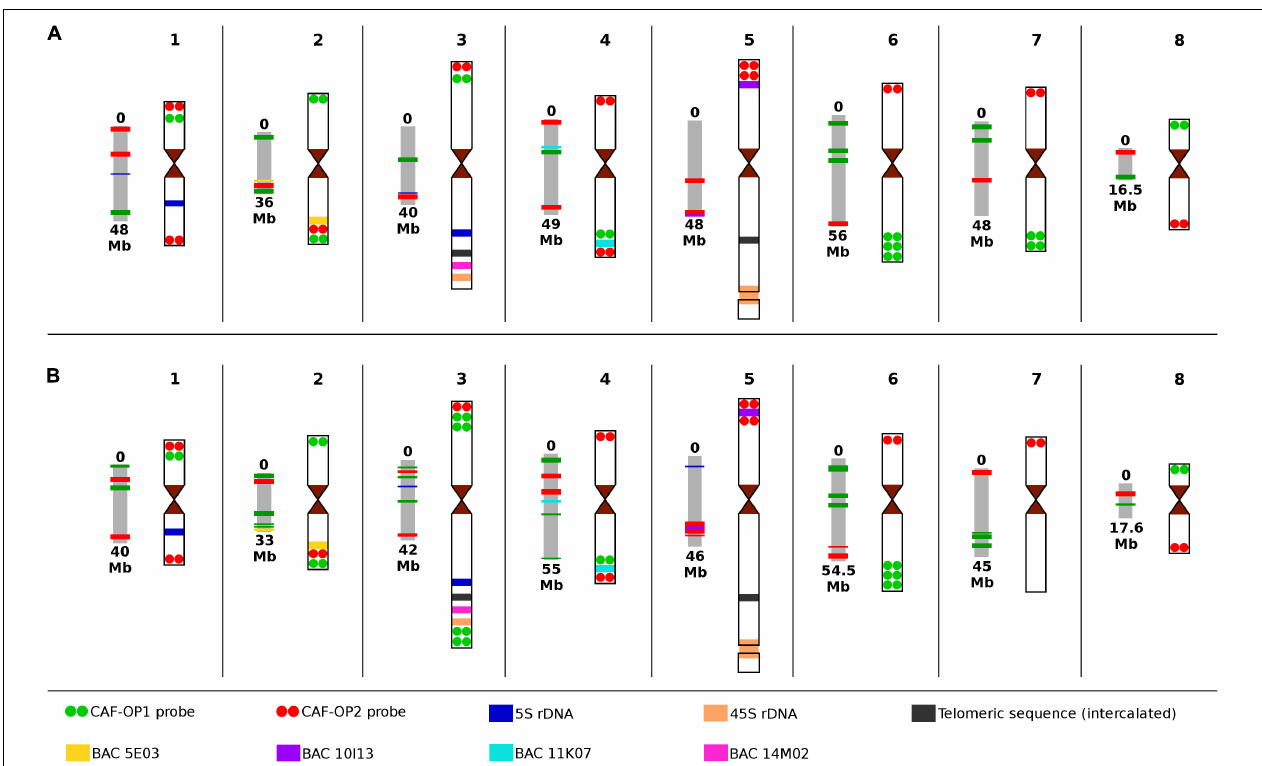
FIGURE 3 | Scheme of pseudomolecules with corresponding chromosome idiograms of the two types of chickpea with the positions of all cytogenetic landmarks and painting probes used in this study. (A) Cicer arietinum CDC Frontier, kabuli type; and (B) C. arietinum ICC 1882, desi type. Chromosome nomenclature corresponds to the pseudomolecules of Varshney et al. (2013) and Parween et al.